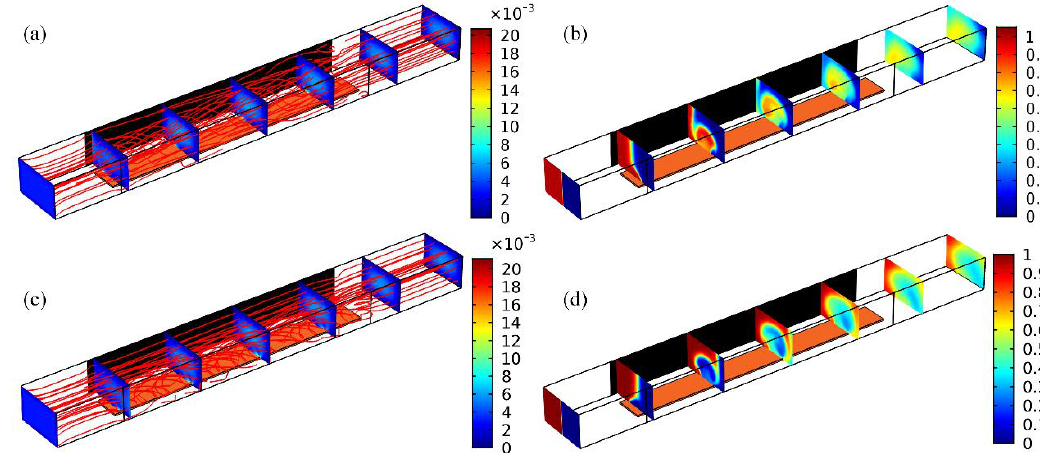
Figure 5. Calculation result of sample mixing behavior via field-effect-reconfigurable ICEO vortex flow field under distinct gate polarities and a fixed driving voltage V D = 8 V, the device performance is improved greatly, taking into consideration an additional electrohydrodynamic torque exerted on the phase boundary. ( a , b ) Nanoparticle mixing reinforced by a single dominating ICEO vortex with anticlockwise recirculation as the gate voltage V G = 2 V is lower than the balance potential V D /2 = 4 V ( V G − V D /2 = −2 V, negatively polarized GE), with mixing performance γ = 76.1%, ( a ) a streamline and cross-sectional magnitude plot of the helical flow field rolling counterclockwise (unit: m/s), ( b ) a multi-slice magnitude plot of sample concentration distribution (unit: mol/m 3 ). ( c , d ) Mixing behavior with clockwise ICEO vortex as the gate voltage V G = 6 V is beyond the neutral one V D /2 = 4 V ( V G − V D /2 = 2 V, positive gate polarity), with same device efficiency γ = 76.1% owing to a mirror image of the gate voltage offset, ( c ) a streamline and cross-sectional magnitude plot of the helical streamlines in clockwise rotating direction (unit: m/s), ( d ) a multi-slice surface plot of nanoparticle concentration distribution (unit: mol/m 3 ).